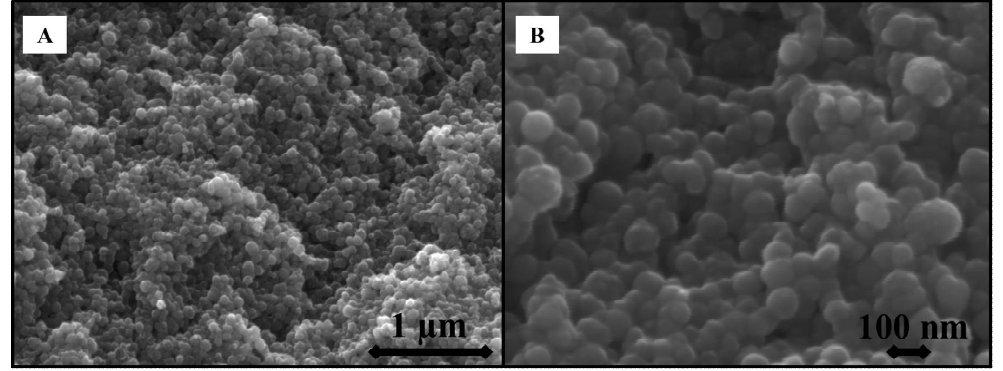
Figure 2. Scanning electron microscopy (SEM) of the SWNH-monolithic solid at 27,000× ( A ), and 70,000× ( B ) magnification.